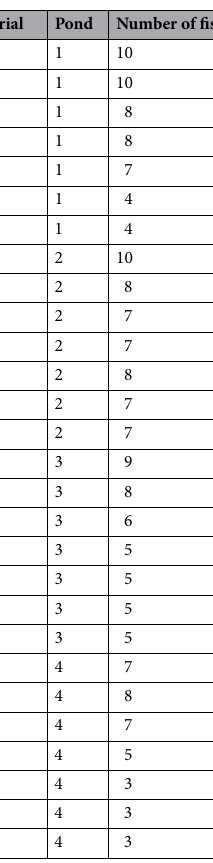
where r i is a unit vector pointing from school’s center of mass towards the position of the i -th fish. This quantity represents the normalized average values of the fish angular momentum and it is constrained to interval [0, 1]. The lower bound of O r represents a situation with no rotation, while the upper bound indicates a strong rotating configuration. The results of Fig. 3 were obtained considering only trials with five or more fish; however, our conclusions remain the same when considering the entire data set. Interaction networks. We use the same synchronized trajectories defined in the previous section to create the interaction networks. For a given trial and pond with five or more fish, we select all positions at a particular time t and create the Voronoi diagram. This diagram is a partitioning of the fish positions plane into convex polygons so that each polygon contains the position of one fish, and every point within the polygon is closer to this particular fish than to any other fish (see black lines of Fig. 4A for an example). Using the Voronoi diagram at time t , we create a graph g t = (ν , ε) where vertices ν correspond to fish and the set of edges ε connects all pairs of individuals that are neighbors in the Voronoi tessellation (see orange lines of Fig. 4A for an example). Finally, we combine these graphs g t using non-overlapping time intervals of length (cid:31) t to create a weighted network G τ = ( V , E , W ) where τ stands for the central point in the time interval, vertices V represent fish, the set of edges E connect all pairs of individuals that were neighbors at least once within the time interval, and W is the set of edge weights representing the fraction of time a pair of individuals remained neighbors during the time interval divided by the number of fish minus one. The results of Fig. 3 were obtained for (cid:31) t = 10 min; however, sensitiv- ity analysis reveals similar results when considering other time intervals (see Fig. S7). Furthermore, we consider a network to represent the under shade category when more than 10% of fish positions are localized under the shade structures within the time interval (sensitivity analysis reveals similar results when considering different thresholds, as shown in Fig. S8). Network measures. Average weighted degree. The weighted degree κ of a vertex is the sum of all weights of its incident edges 42 . The average weighted degree k of a network is the average value of the weighted degree of all network vertices.